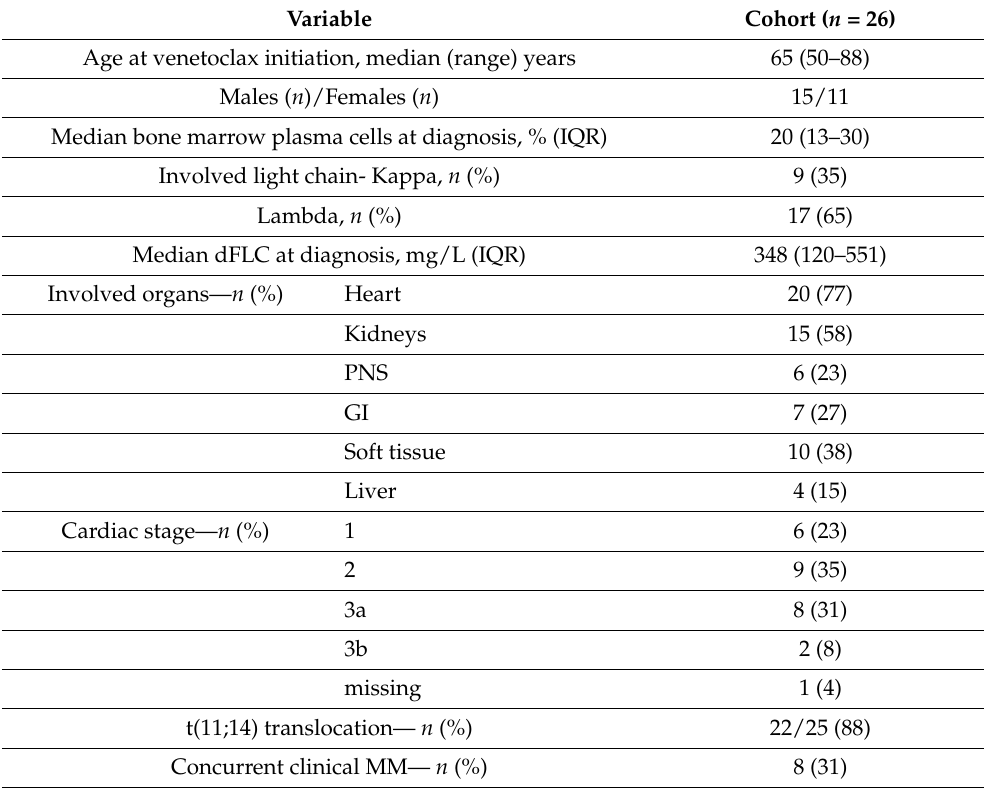
Table 1. Characteristics of the 26 AL amyloidosis patients included in the